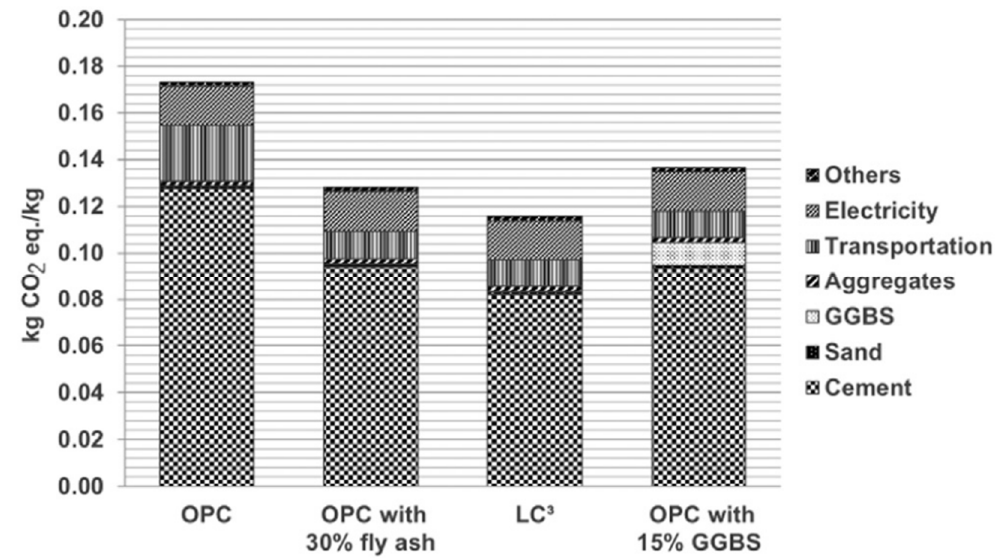
Table 1. Input data of different technologies in Cuban cement industry [3]. Reprinted with permission from Ref. [3]. Copyright: 2018, Karen Scrivener. Published by Elsevier.